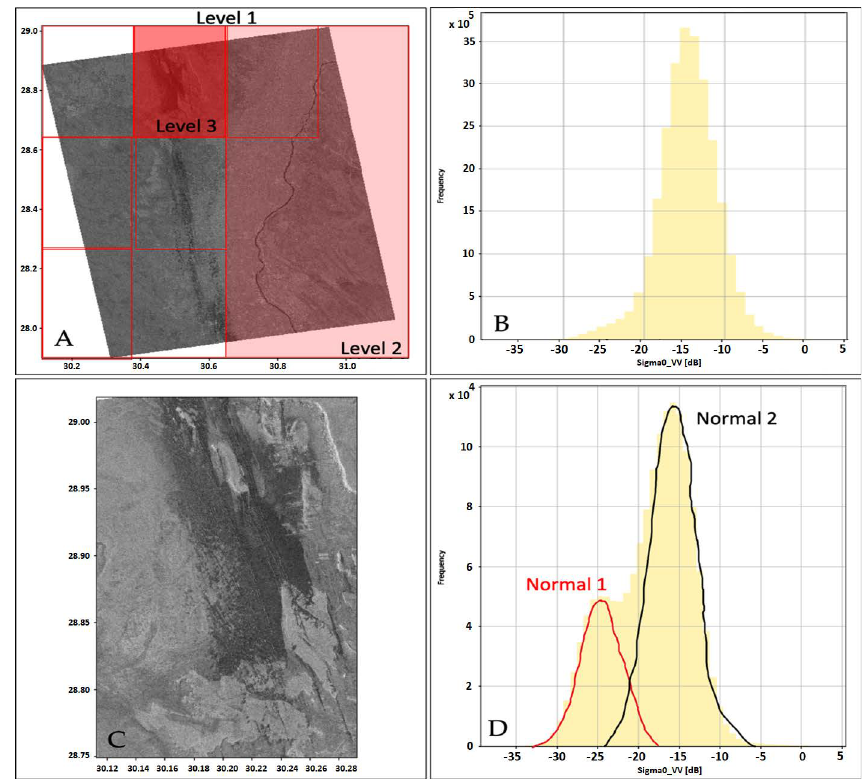
Figure 6. ( A ) Sentinel-1 image acquired over Egypt including the South Rayan dune field showing three levels of tiles similar to those employed in the HSBA. ( B ) Level 1 (full scene) backscatter histogram. ( C ) Sentinel-1 image zoomed over the Level 3 tile colored in red in ( A ), and ( D ) its corresponding histogram, highlighting the separability of the normal distributions of the dune backscatter (red Gaussian) in the lower part and the other Gaussian in black for the non-dune